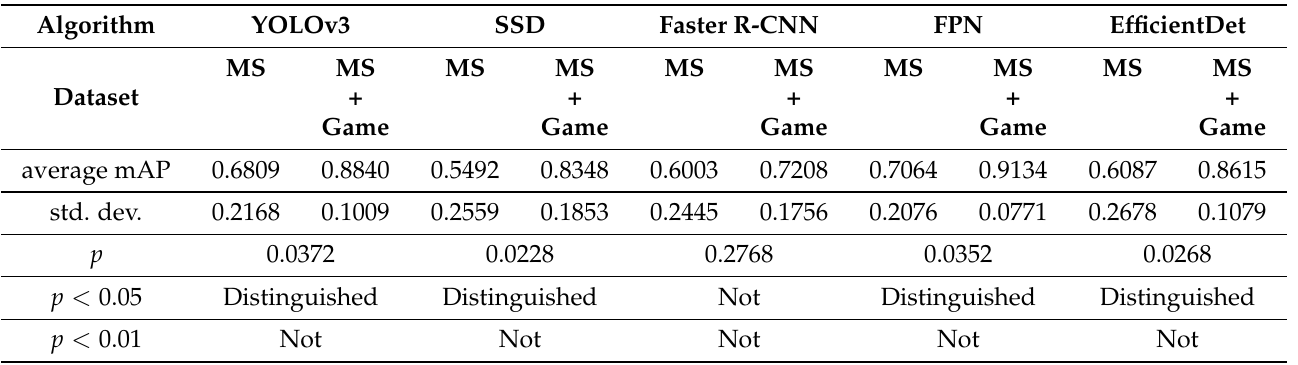
Table 9. p values for the mAPs from five object detection algorithms. We compared the algorithms trained by MS COCO and retrained by MS COCO with game scenes. Note that MS COCO is abbreviated as MS in the table.